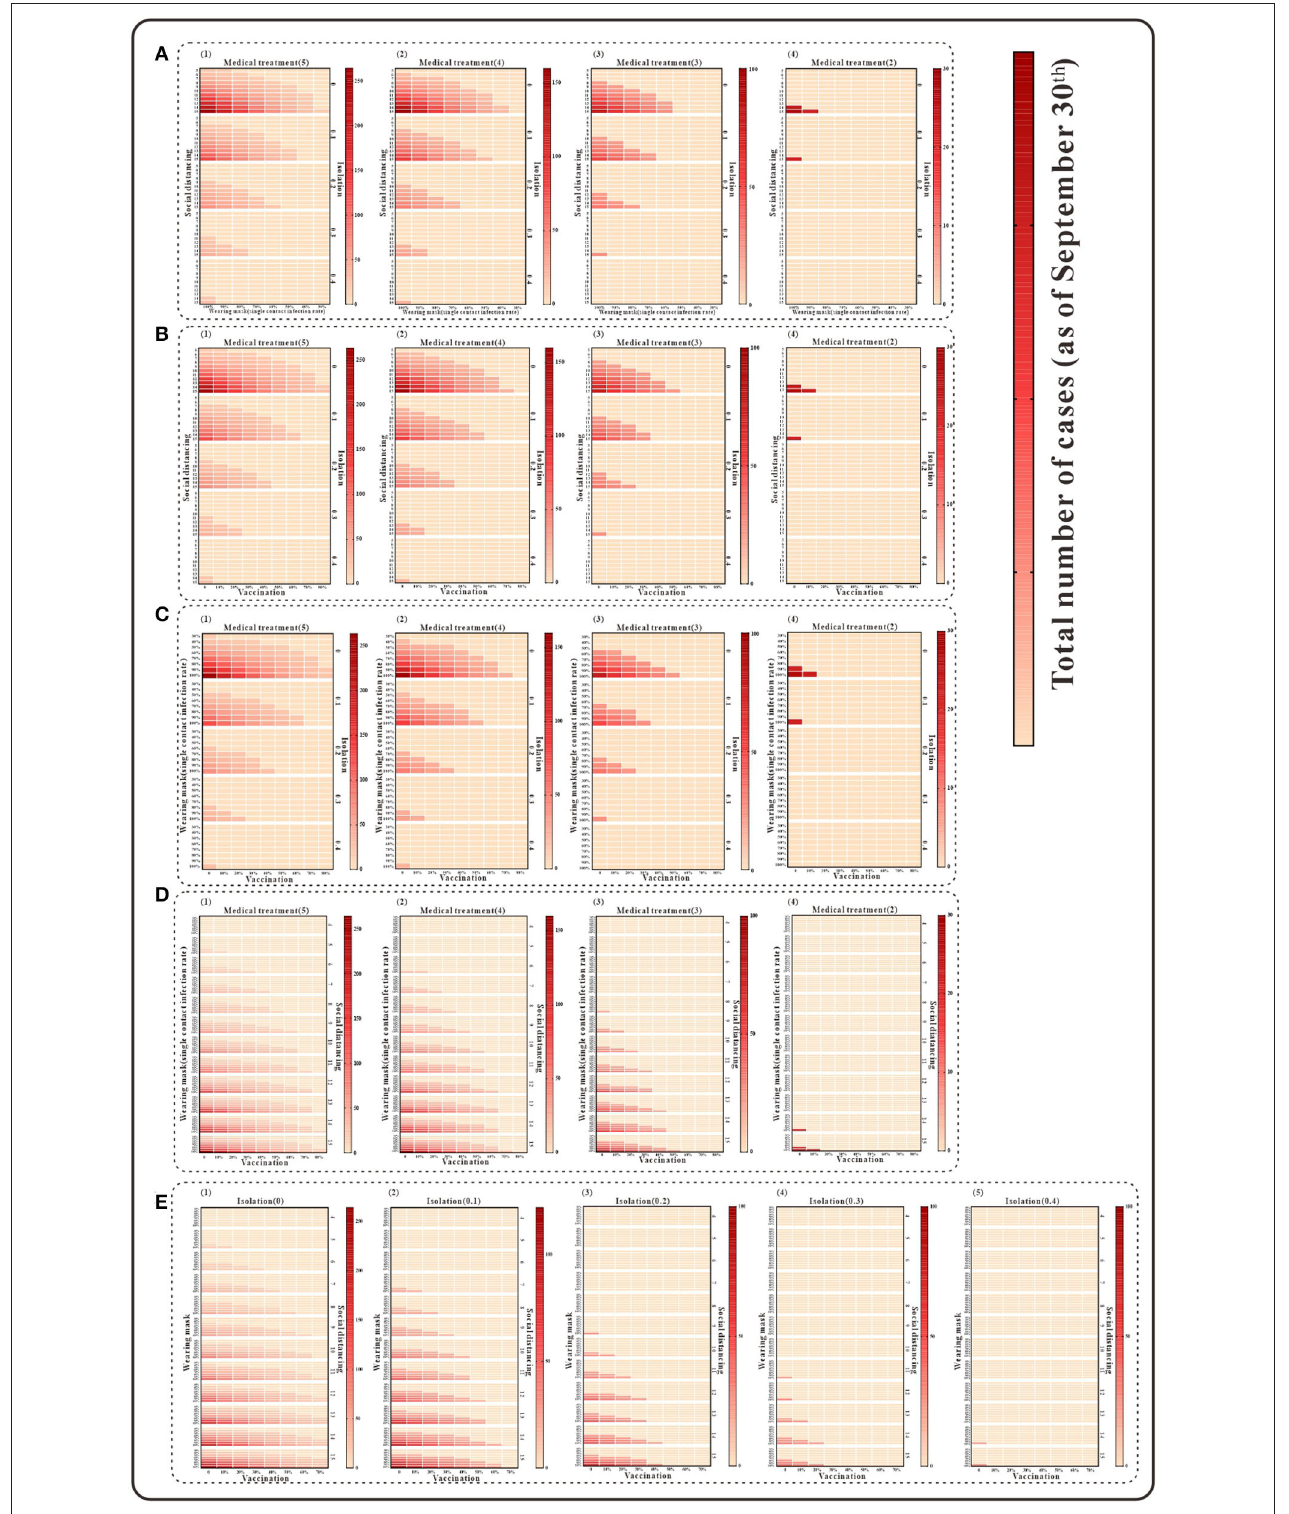
FIGURE 7 | The simulation results of a mix of four interventions in Xiamen City, China, 2021. (A) Medical treatment and isolation and social distancing and wearing mask; (B) medical treatment and isolation and social distancing and vaccination; (C) medical treatment and isolation and wearing mask and vaccination; (D) medical treatment and vaccination and social distancing and wearing mask; and (E) isolation and vaccination and social distancing and wearing mask.